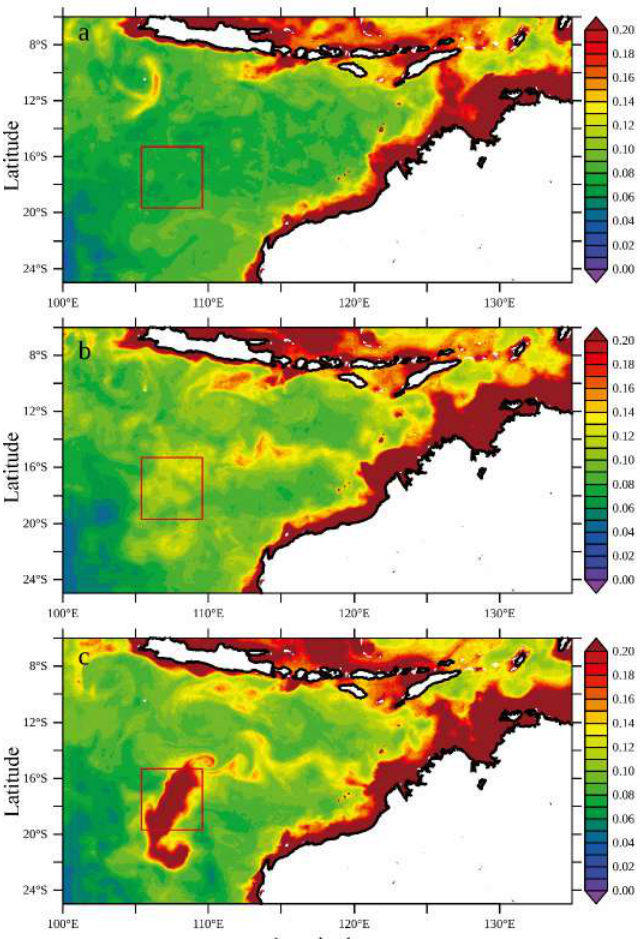
Fig. 7: Distribution of sea surface Chl‐a (color in mg/m 3 ): (a) before Cyclone Marcus (11‐17 March 2018), (b) during Cyclone Marcus (18‐25 March 2018), (c) after Cyclone Marcus (26‐31 March 2018)